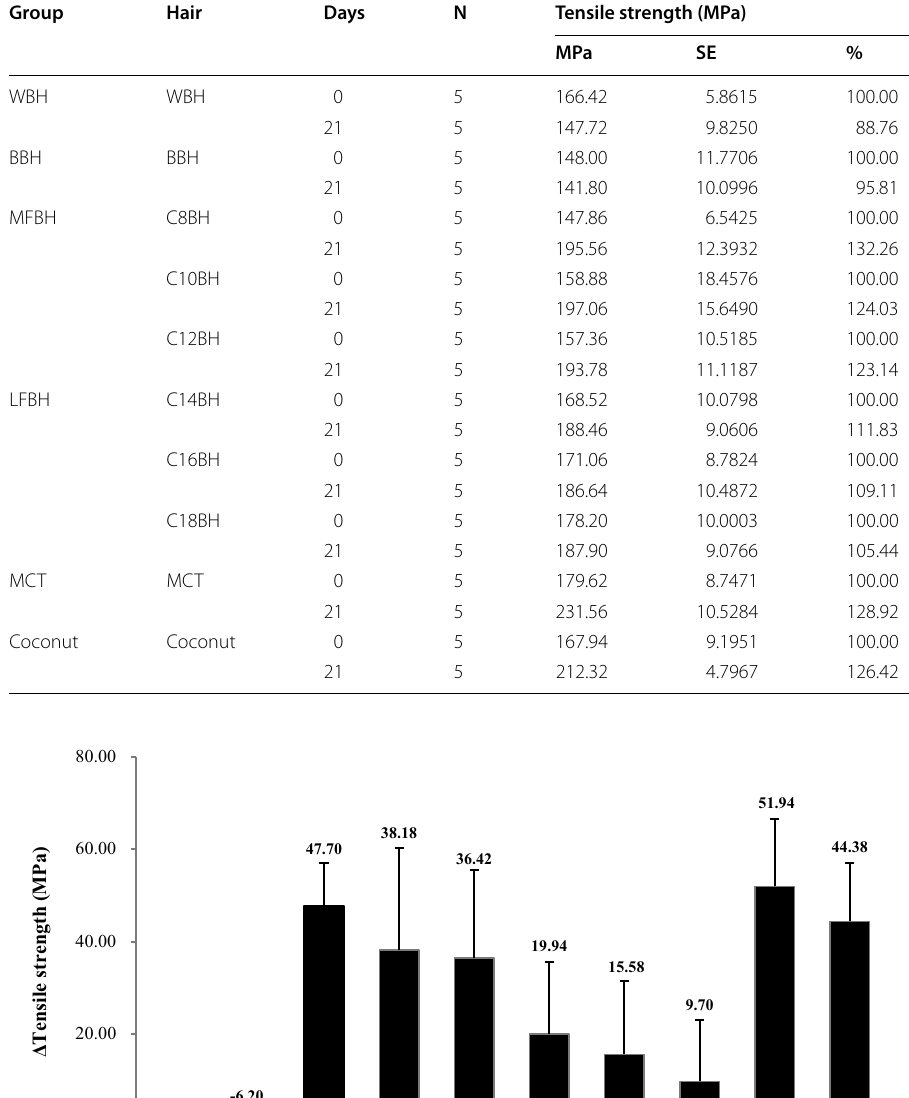
Table 6 Tensile strength of bleached hair (BH) before and after 21 days of applying different hair treatments Group